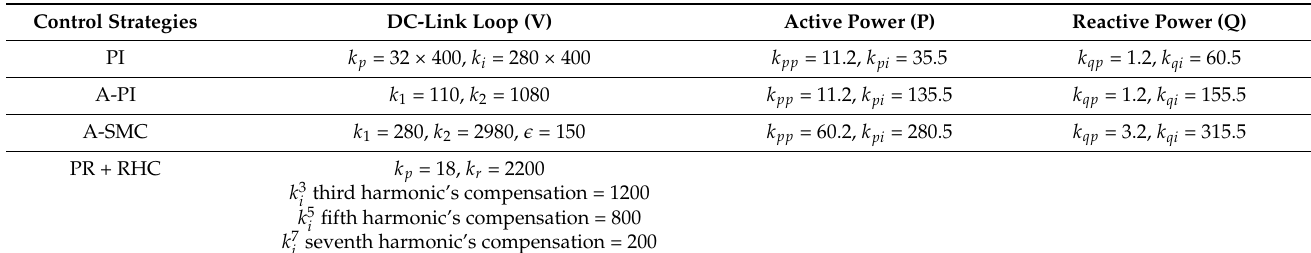
Table A3. Control gains with PV power feedforward